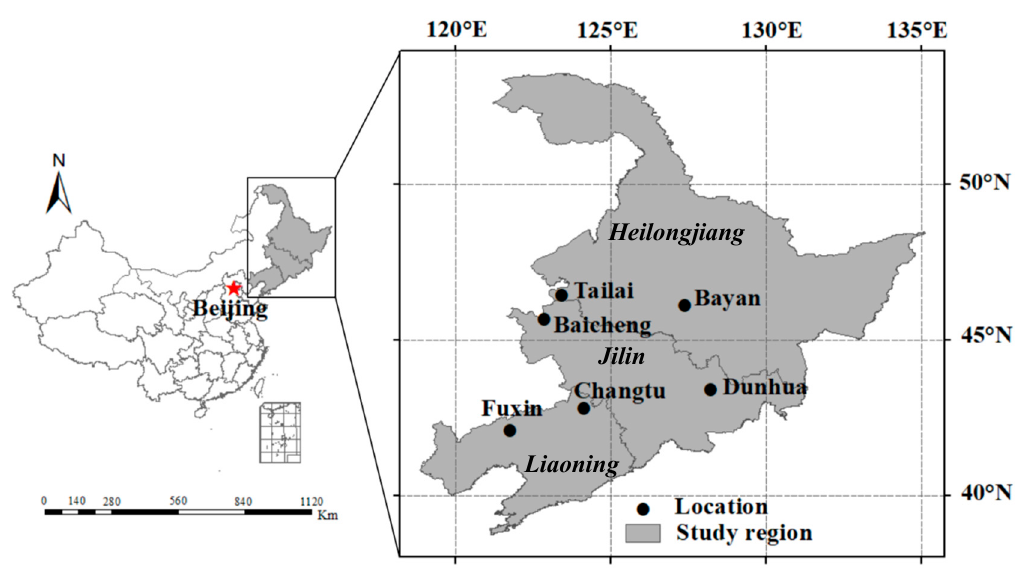
Figure 1. The locations selected for simulation of maize yield in Northeast China (NEC). Solid circles indicate locations used for simulating yield (names are shown in regular font). Lines show provincial boundaries. Province names are in italics. The left figure is a map of China that indicates the location of NEC.